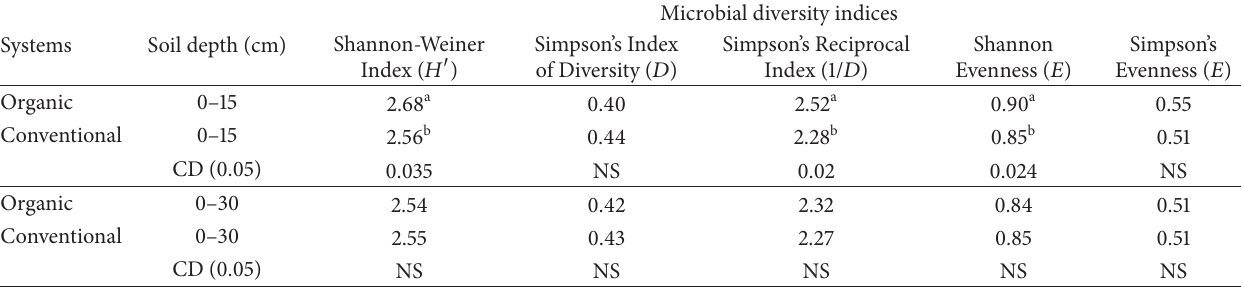
Table 5: Organic and conventional method of coffee farming on microbial diversity indices.